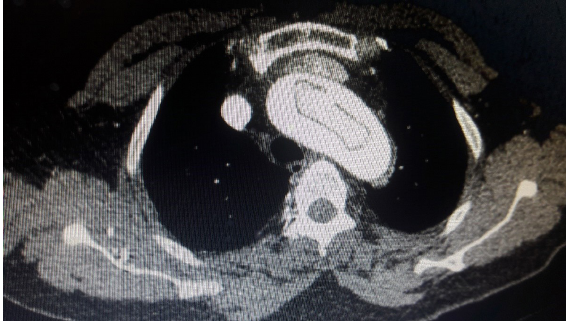
Figure 5. Crescent Sign in Non-contrast CT-Scan. Note . CT: Computed